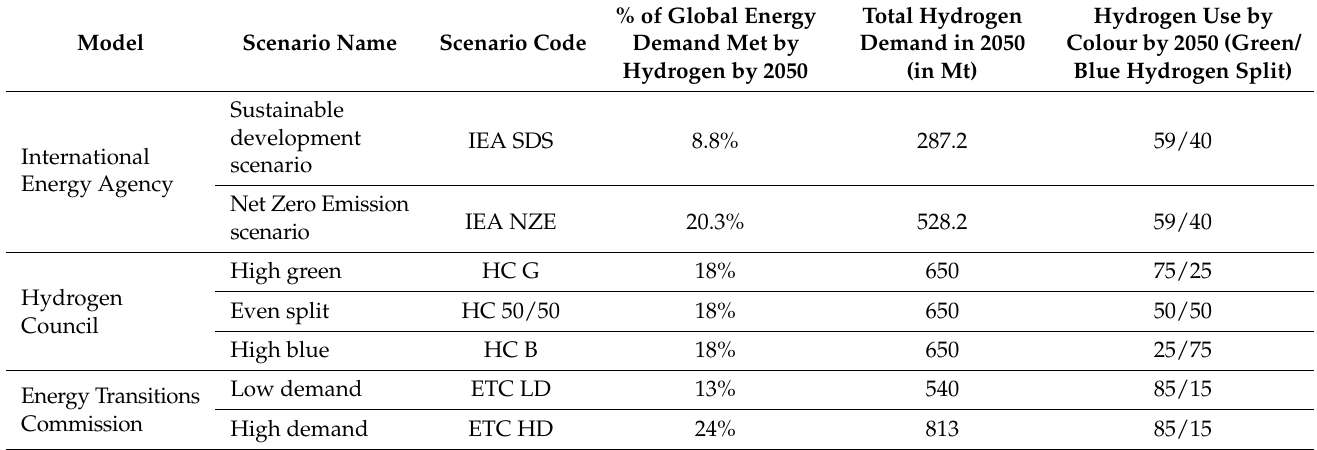
Table 1. Overview of scenarios from global energy models incorporating hydrogen. Table includes the resulting cumulative emissions from annual demand of hydrogen and associated GHG emissions according to the estimated technological production split.